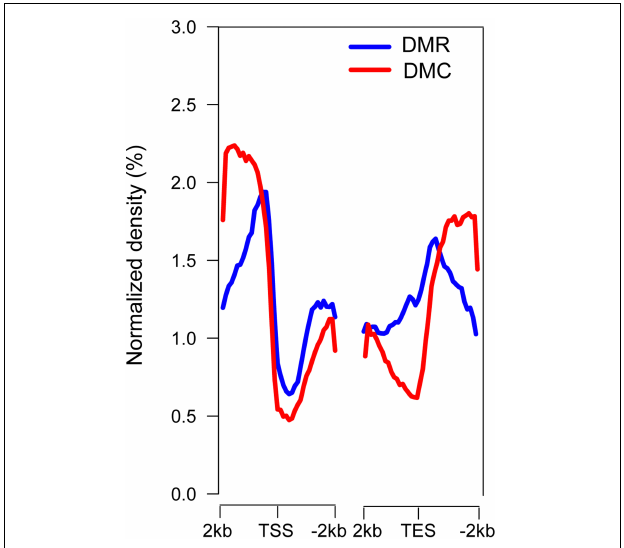
FIGURE 2 | Distribution of DMRs and DMCs in genic regions. TSS, transcriptional start site; TES, transcriptional end site. TSS and TES exhibited the lowest densities of DMRs and DMCs, and the 5 (cid:48) upstream and 3 (cid:48) downstream gene regions exhibited higher densities of DMRs and DMCs. The 2 kb regions were divided into 20 bins, and the average methylation levels were